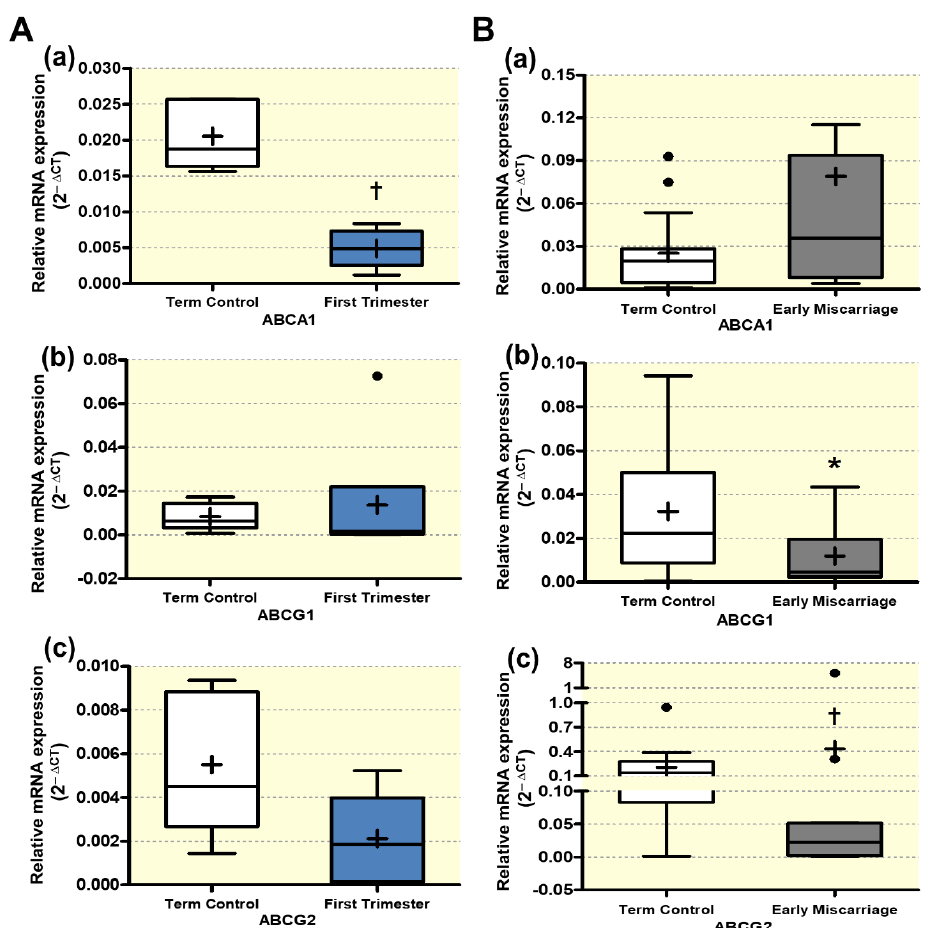
Figure 8. qRT-PCR analysis of ABC transporters . mRNA expression of selected ABC transporters was measured in placentae from ( A ) first trimester and term controls ( n = 6 and n = 5, respectively; Swiss cohort) and ( B ) EMC patients and term controls ( n = 20 and n = 19, respectively). mRNA abundances of ( a ) ABCA1, ( b ) ABCG1, and ( c ) ABCG2 are presented as 2 −ΔCT (ΔCT= CT value of target gene—CT value of the mean of reference genes β -actin, GAPDH, YWHAZ, B2MG, L19, hTBP, and hsUBQ). Data are presented as mean (x), median (-), and Tukey box and whiskers (1.5 times interquartile range). ABCG1 was significantly lower, whereas ABCG2 mRNA expression increased in ECM. Statistical significance was evaluated by using two-tailed Mann – Whitney test for comparing first trimester vs. term controls (Swiss cohort) ( A ) and EMC vs. term controls ( B ); † ( p ≤ 0.01), * ( p ≤ 0.05). Abbreviations: β -actin , beta-actin; GAPDH , Glyceraldehyde-3-phosphate dehydrogenase; YWHAZ , 14-3-3 protein zeta/delta; B2MG , beta-2 microglobulin; L19 (RPL19), ribosomal protein L19; TBP , TATA-box-binding protein; UBC , ubiquitin. Those ABC transporters that we found significantly regulated on transcript level (ABCG1 and ABCG2) were further evaluated on protein level by performing Western blotting with consecutive densitometric analysis. β -actin served as loading control, and all signals were normalized to this protein. Immunoblotting revealed downregulation of ABCG1 and a clear induction of ABCG2 protein expression in placentae of EMC patients (Figure 9A(b) and 9B(b), respectively). Similar to the mRNA results, no significant differ- ences were detected between first trimester and term placenta neither for ABCG1 nor for ABCG2 (Figure 9A(a) and 9B(a), respectively). These findings demonstrate that ABCG1